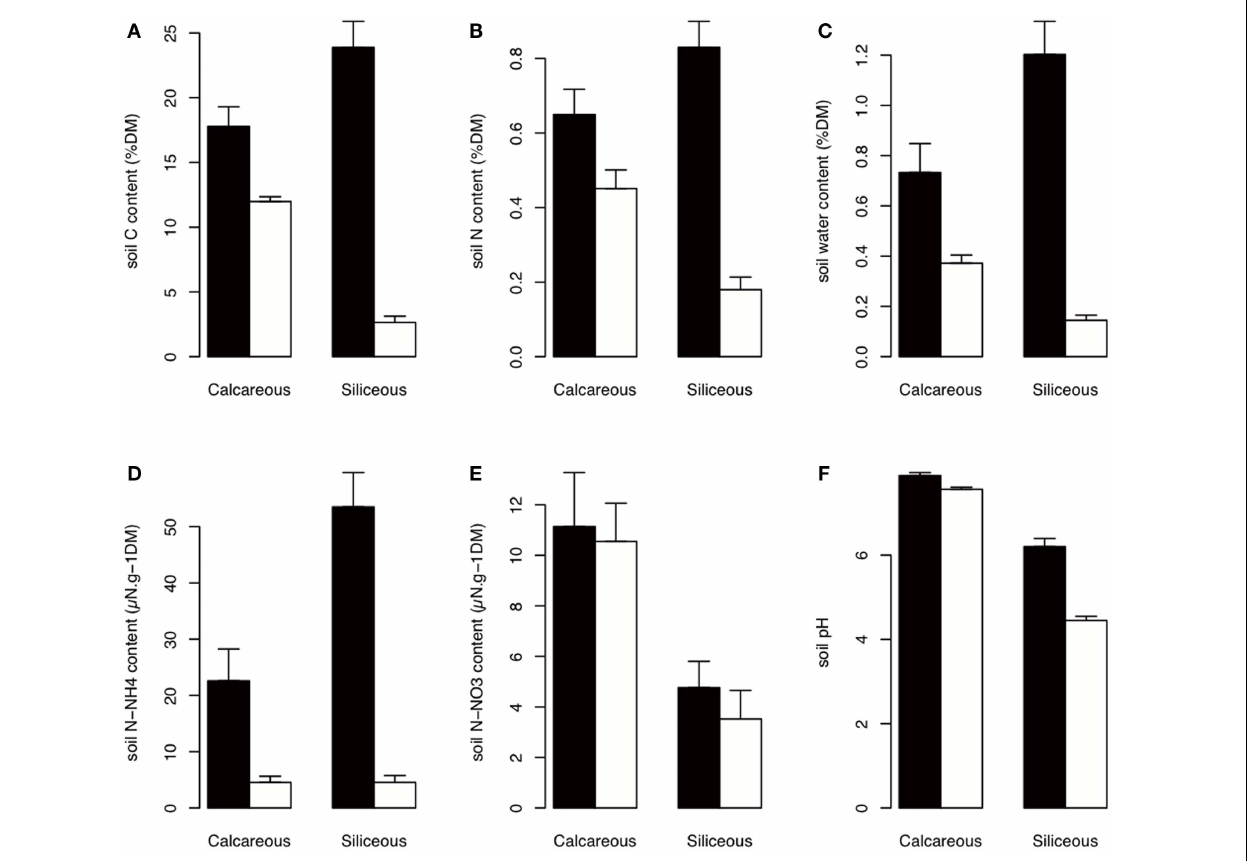
represent SD. (A–F) are total carbon content, total nitrogen content, soil water content, ammonium content, nitrate content, and soil pH, respectively. DM, dry